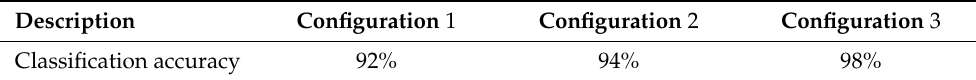
Figure 9. Classification accuracy among seven different human activities. ( a ) Micro-Doppler signatures-based classification accuracy; ( b ) interferometric signatures-based classification accu- racy; ( c ) dual micro-motion signatures-based classification accuracy. Table 3. Classification accuracy level of different human